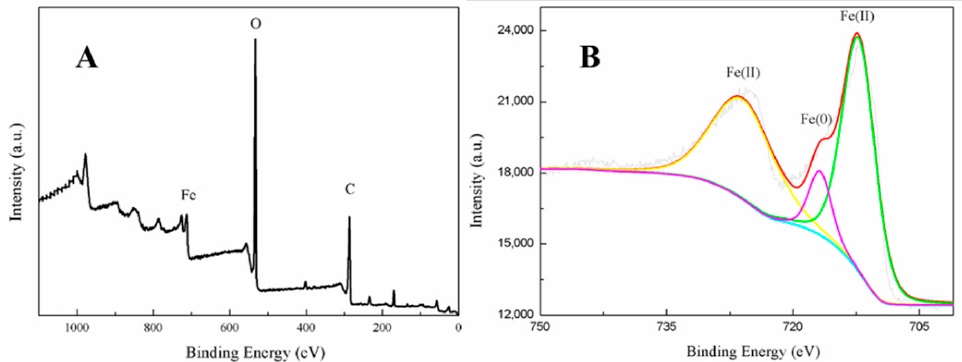
Figure 4. XPS images of n Fe, full scan image ( A ) and expanded Fe region ( B ).